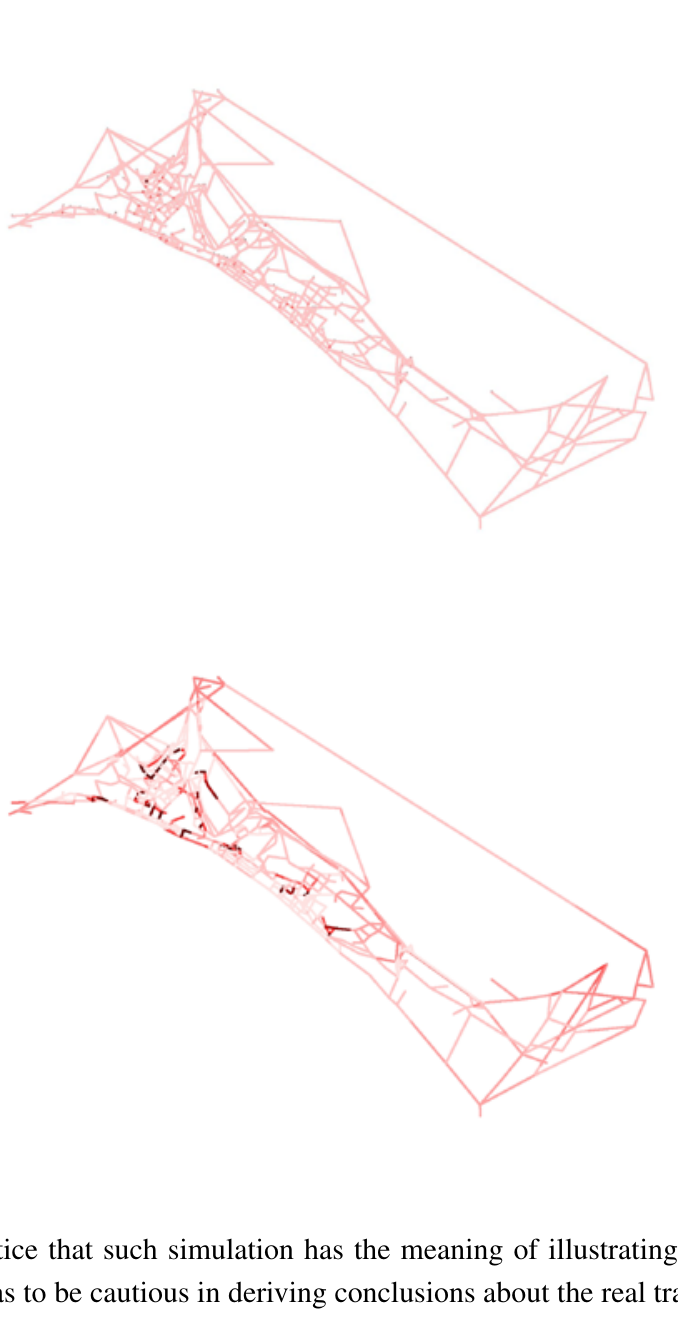
Figure 5. The full network of Salerno: before (top) and after (bottom) the